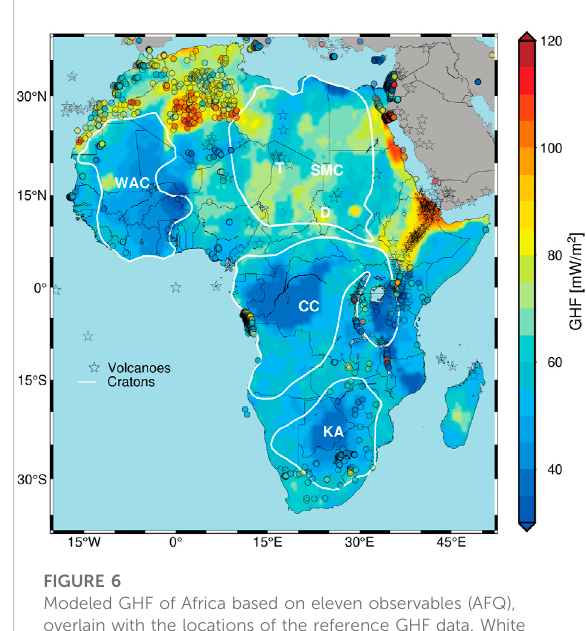
FIGURE 6 Modeled GHF of Africa based on eleven observables (AFQ), overlain with the locations of the reference GHF data. White polygons represent the major cratonic units in Africa, D = Darfur Dome; T = Tibesti Massif. Asterisks = distribution of